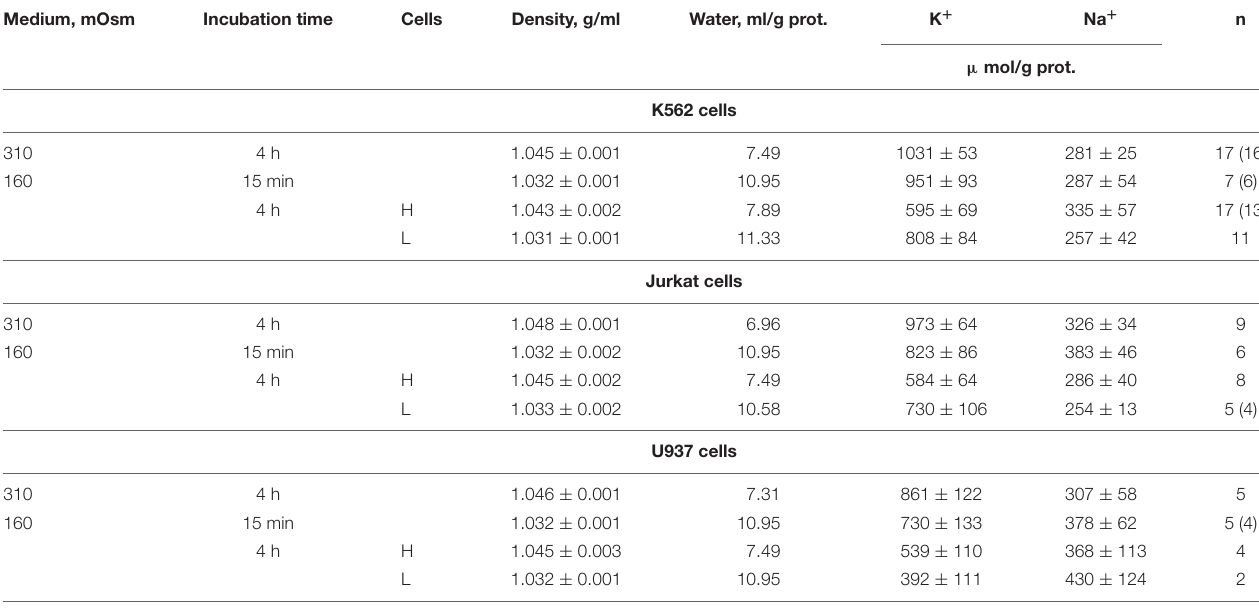
TABLE 6 | Changes in the buoyant density and the K + and Na + content in K562, Jurkat, and U937 cells after transfer to a hypoosmolar medium (160 mOsm). Medium, mOsm Incubation time Cells Density, g/ml Water, ml/g prot. K + Na + n µ mol/g prot. K562